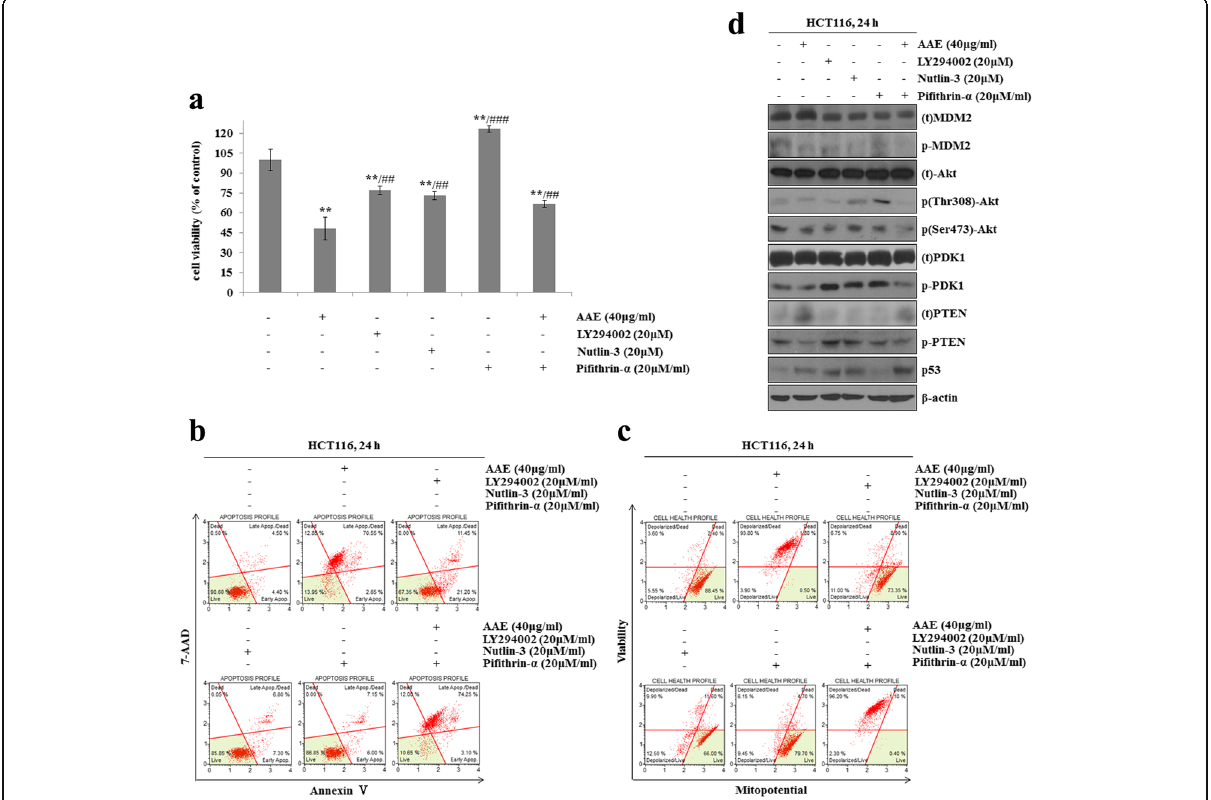
Fig. 5 AAE-induced apoptosis by p53-independent manner. Cells were treated with 20 μ M LY294002, 20 μ M Nutlin-3, 20 μ M Pifithrin-á and 40 μ g/ml AAE for 24 h. a Cells viability was measured by MTT assay (20 μ M LY294002, 20 μ M Nutlin-3, 20 μ M Pifithrin-á 40 μ g/ml AAE). The statistical analysis of the data was carried out by use of an an T-test. */#p < 0.05, **/##p < 0.01 and ***/###p < 0.001 (each experiment, n = 3). b Apoptotic effects of different concentration AAE were evaluated by Muse ™ Annexin V and Dead Cell Assay Kit. HCT116 were treated with 20 μ M LY294002, 20 μ M Nutlin-3, 20 μ M Pifithrin-á 40 μ g/ml AAE for 24 h. c Mitochondria membrane potential were evaluated by Muse ™ Mitopotential kit. HCT116 were treated with and 40 μ g/ml AAE for 6 h. The expression of PTEN, PDK1, Akt (Thr308 and Ser473), MDM2, p53 were analyzed by western blot